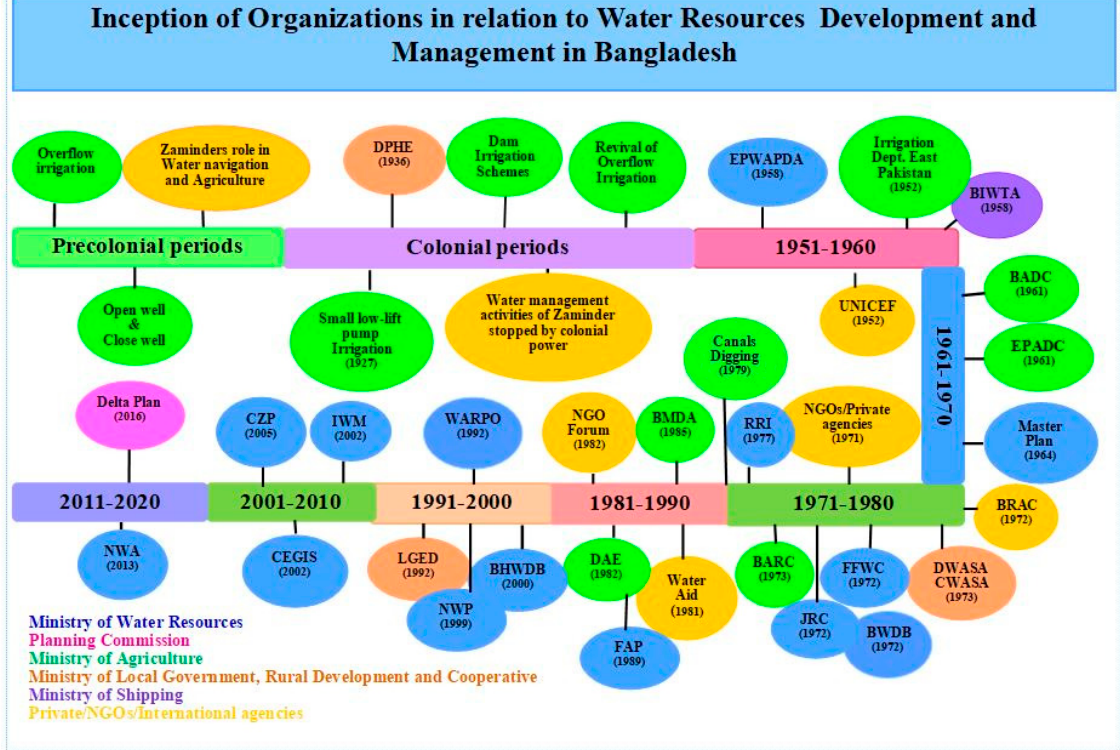
Figure 2. Water sector institutional framework in Bangladesh